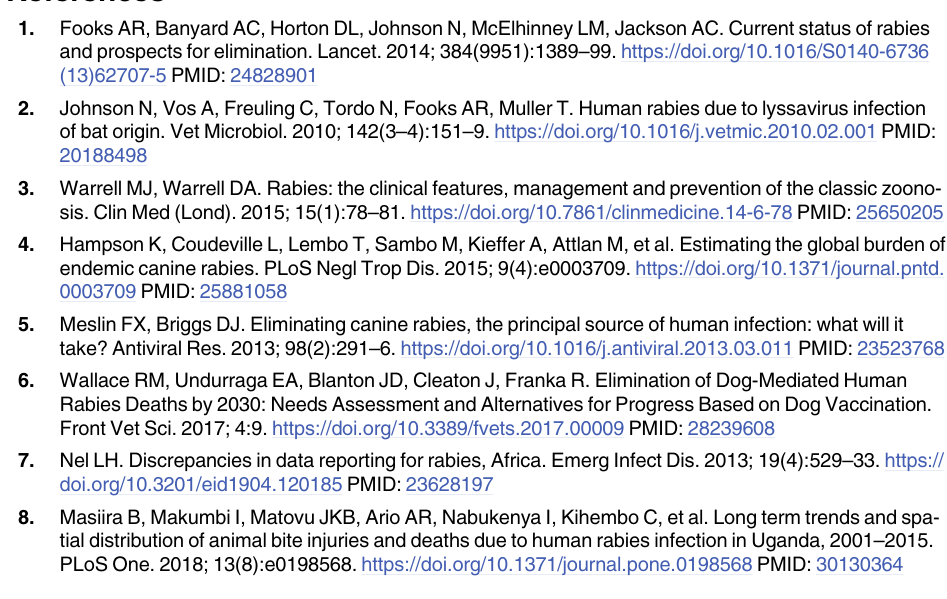
S1 Table. Characteristics of villages among the 798 surveyed households, Uganda, 2013. S2 Table. Assessment of domicile